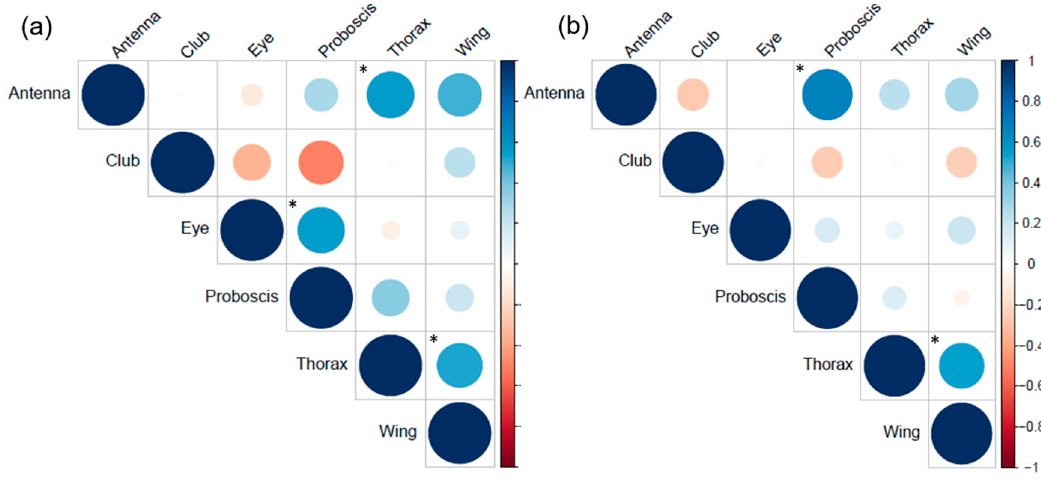
Figure 2. Correlation matrices between the different sensory traits measured in this study and body size in ( a ) females ( n = 15) and ( b ) males ( n = 20) of Pieris napi . Colours indicate whether the traits increase or decrease in size together (blue and red, respectively). The colour scale indicates the power of the correlation (lighter colours indicating a weak correlation, darker colours indicating a strong correlation) and the size of the circles indicates their level of significance. Correlations that produced significance levels below 0.05 are indicated with *.